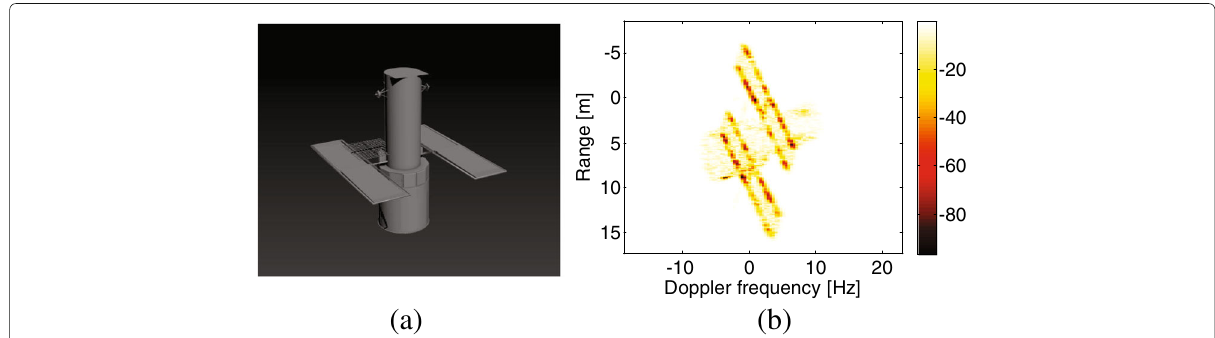
Fig. 9 Simulated HST configuration and the simulated ISAR images observed by the sensor. a The 3D model of HST. b The simulated ISAR image by the sensor